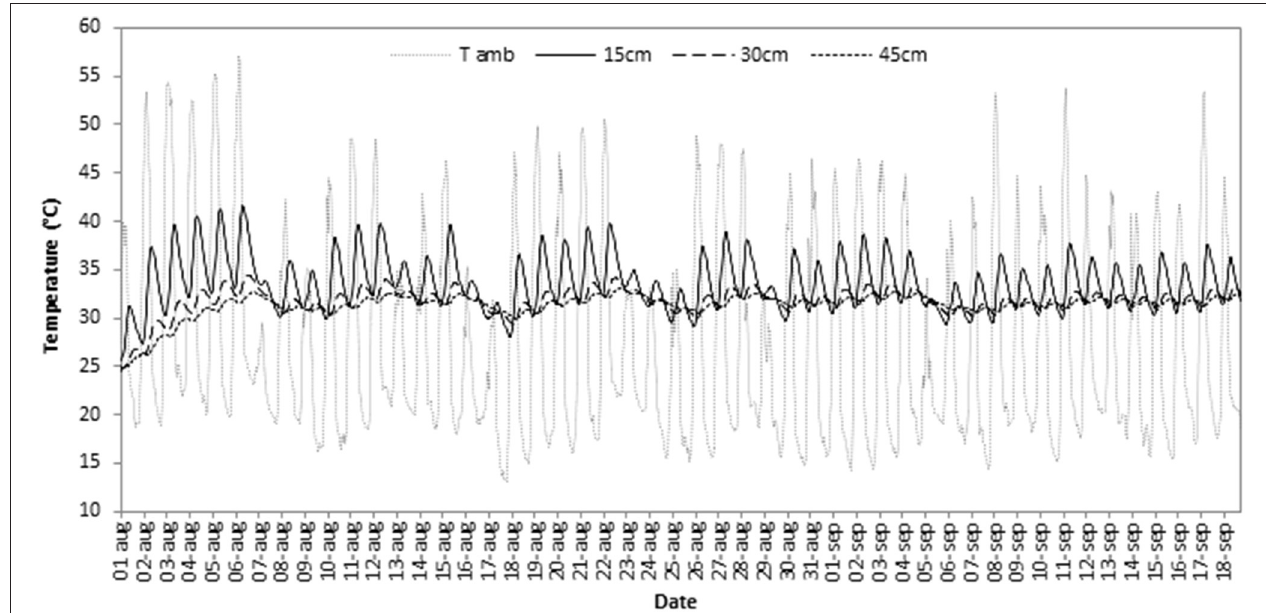
FIGURE 2 | Mean temperatures per hour for each day during seven weeks of biodisinfestation treatment at ambient temperature inside the greenhouse (T amb) and at three different soil depths (15, 30, and 45cm) in the treated